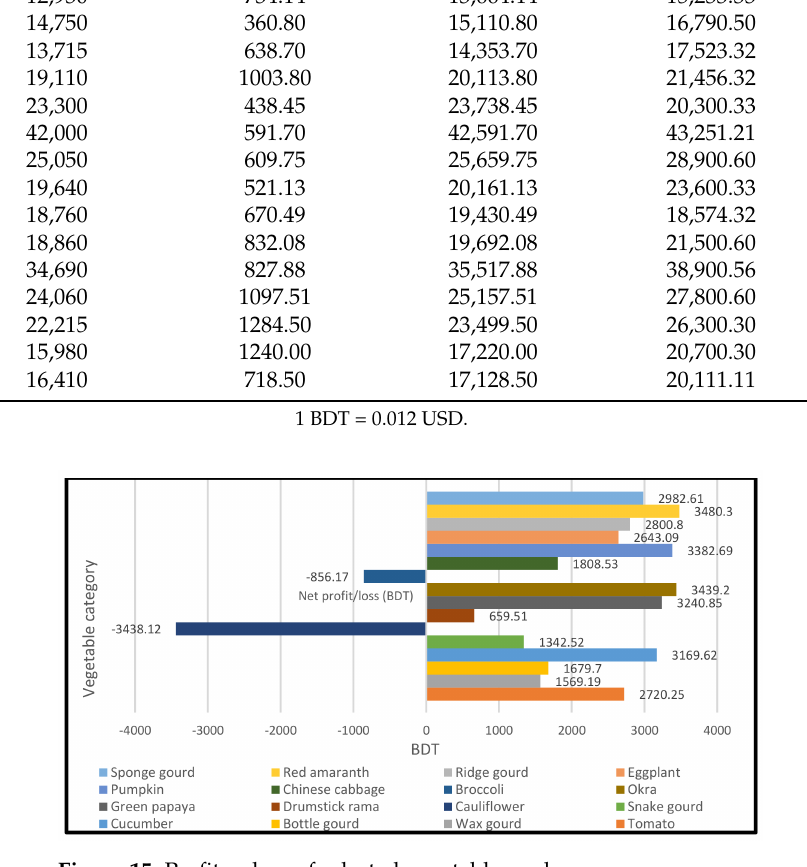
Figure 15. Profit or loss of selected vegetable seeds.